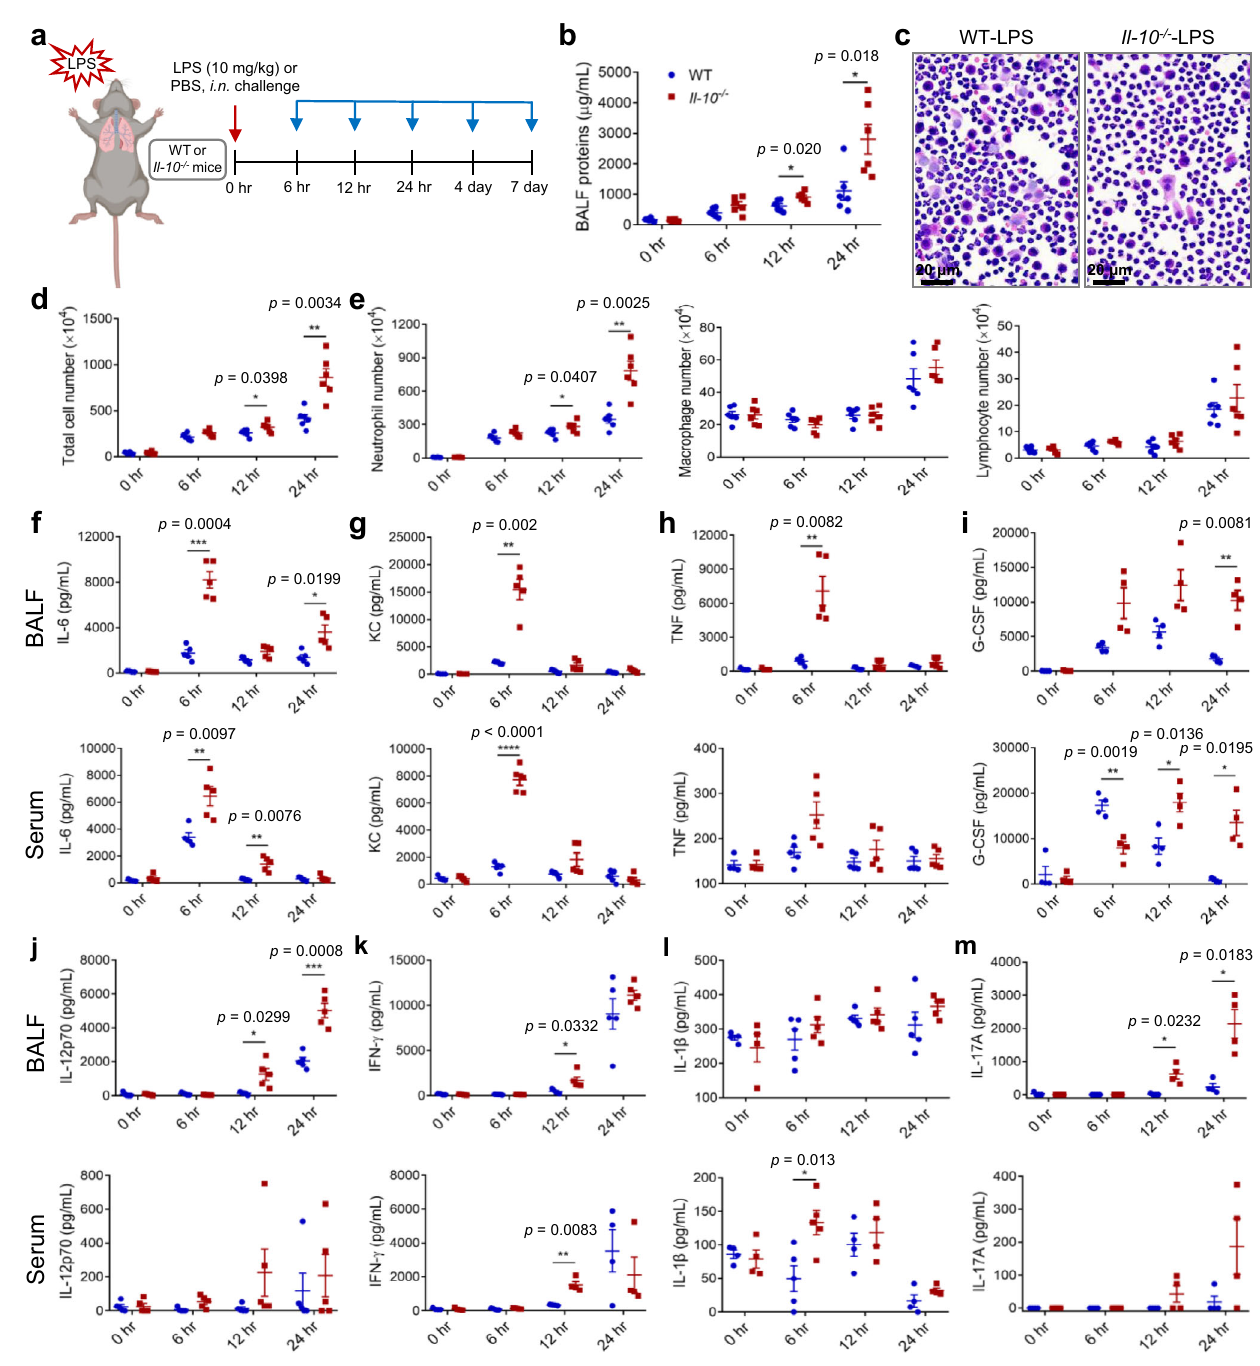
Fig. 1 | IL-10 depletion aggravates neutrophil-predominant in fl ammation fol- lowing LPS challenge. a Experimental strategy for morphological and functional analysis of neutrophils after ALI. WT and Il-10 − / − mice were treated nasally with 10mg/kg LPS or PBS, followed by analyses at 6h, 12h, 24h, 4 d and 7 d after administration. Some fi gure elements were created with BioRender.com. b – e AnimalswereeuthanizedandBALFwasevaluatedfortotalprotein( b ),totalcell number( d ),neutrophil,macrophageandlymphocytenumbers( e )at6h,12h,24h, n =6ineachgroup;aswellasH&Ecellstaining( d )at24hafterLPSchallenge.Scale bars,20 μ m. f – m ProductionofcytokinesinBALFandserumwasevaluatedforIL-6 ( f , n =4, 5, 5, 5 in each time point from WT and Il-10 − / − group both in BALF and serum), KC ( g , n =4, 5, 5, 5 in each time point from WT and Il-10 − / − group both in